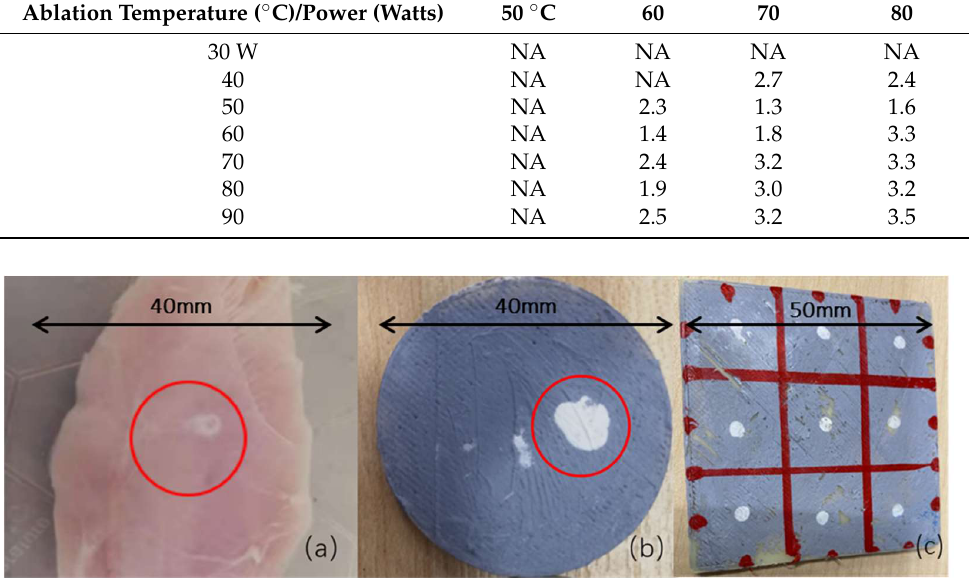
Figure 3. ( a ) Ablation lesion in chicken breast at 70 W, 70 °C, 60 s with a lesion diameter of ~3 mm, ( b ) Layfomm-40 disc with thermochromic paint coating showing the maximum size lesion that could be created at >90 W, >80 °C, 60 s with a lesion diameter of ~7 mm, and ( c ) Layfomm-40 square with thermochromic paint coating showing nine lesions at 70–80 W, 70–80 °C, 60 s with lesion di-